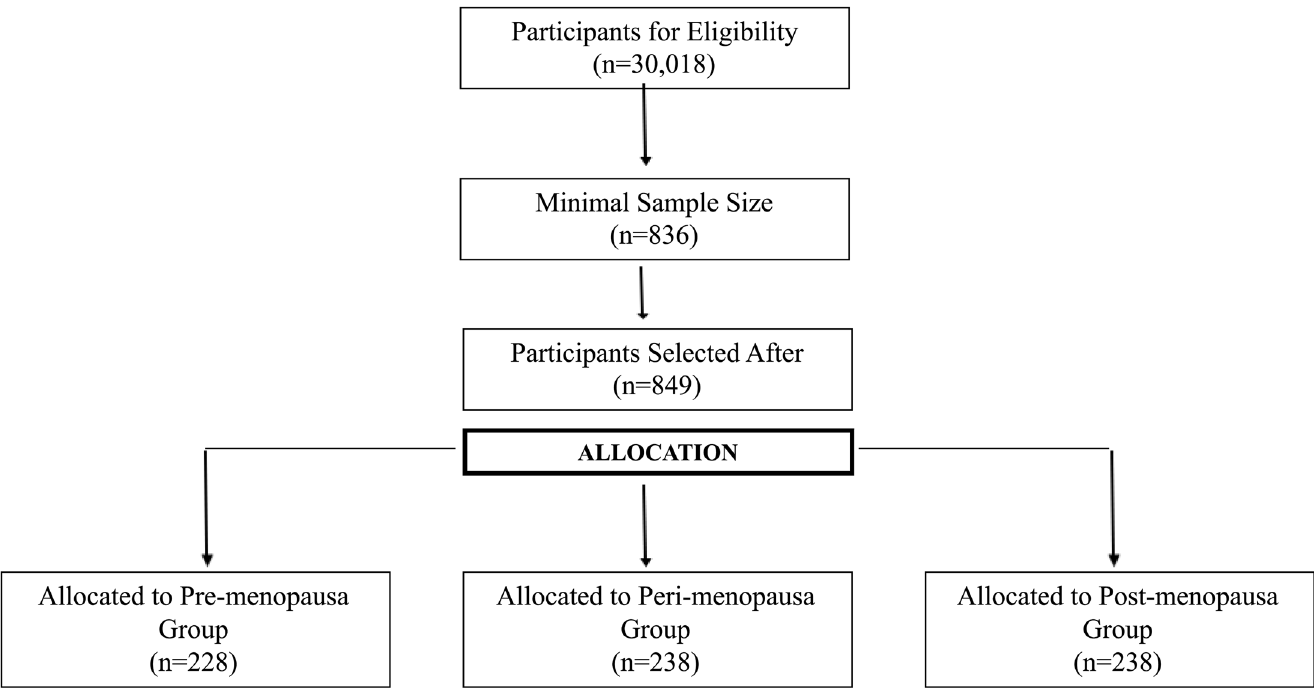
Fig 1. Flowchart of selection process,